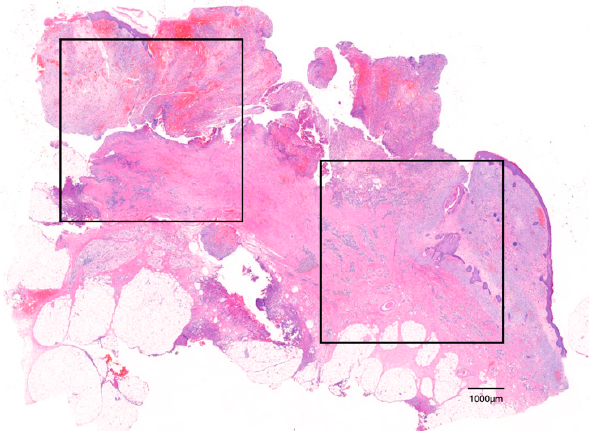
Figure 1. Region of interest (ROI) is indicated. Two visual fields (rectangles) were defined and measured within a scanned section (H&E staining).